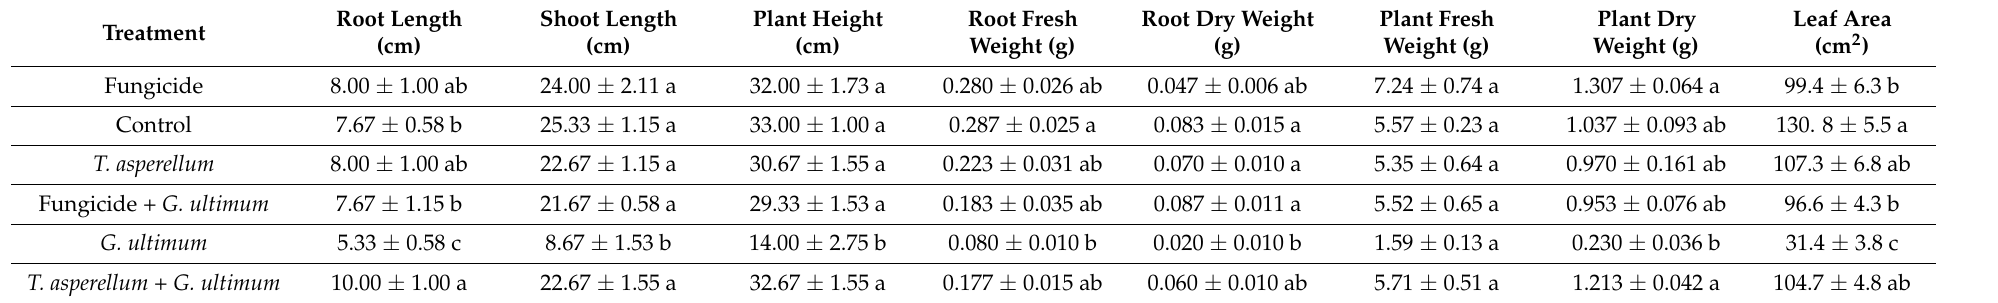
Table 3. Vegetative growth parameters of pea under the action of bioagent and the